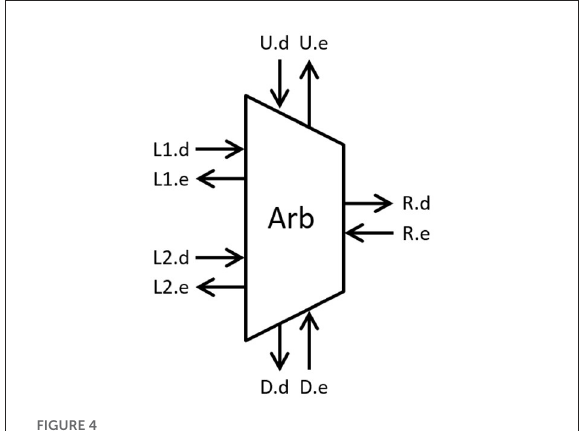
FIGURE4 Arbitration module (request ends with “.d” and enable ends with